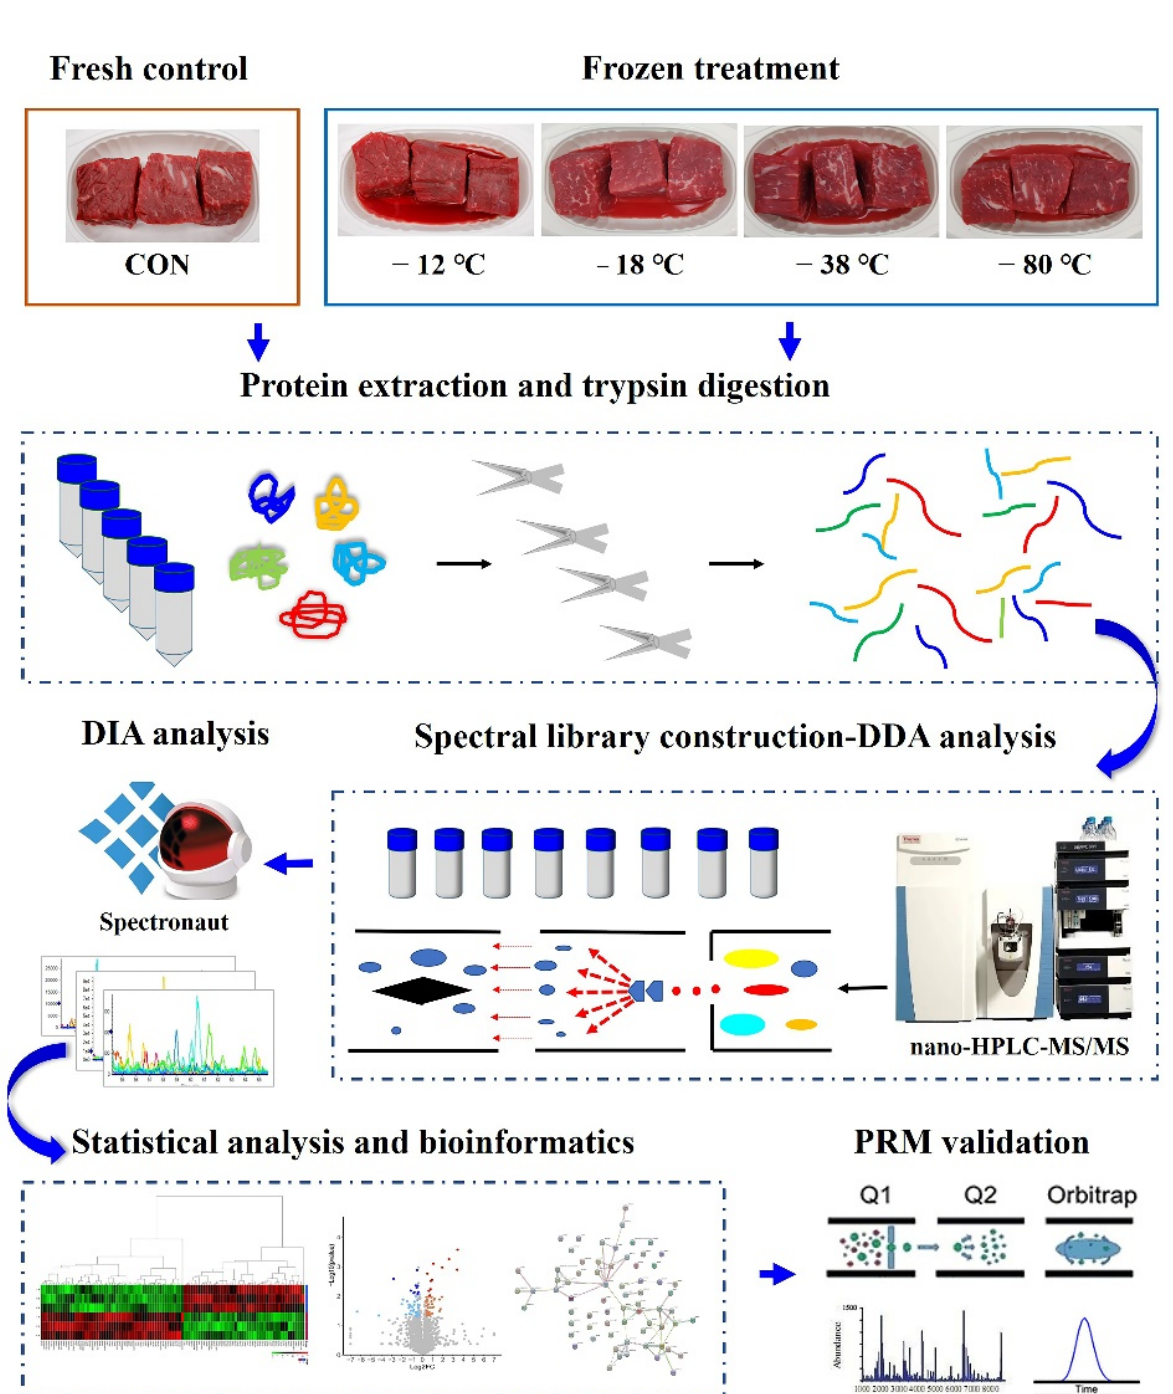
Figure 1. Experimental design and workflow for quantitative proteomic analysis of beef using DIA technology.